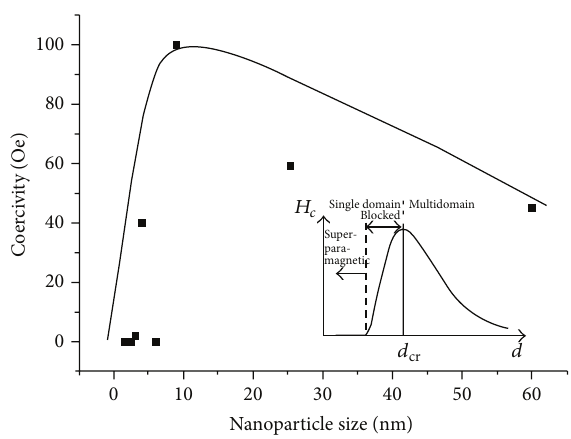
Figure 7: Coercivity as a function of particle size (continuous line is the trend, inset: